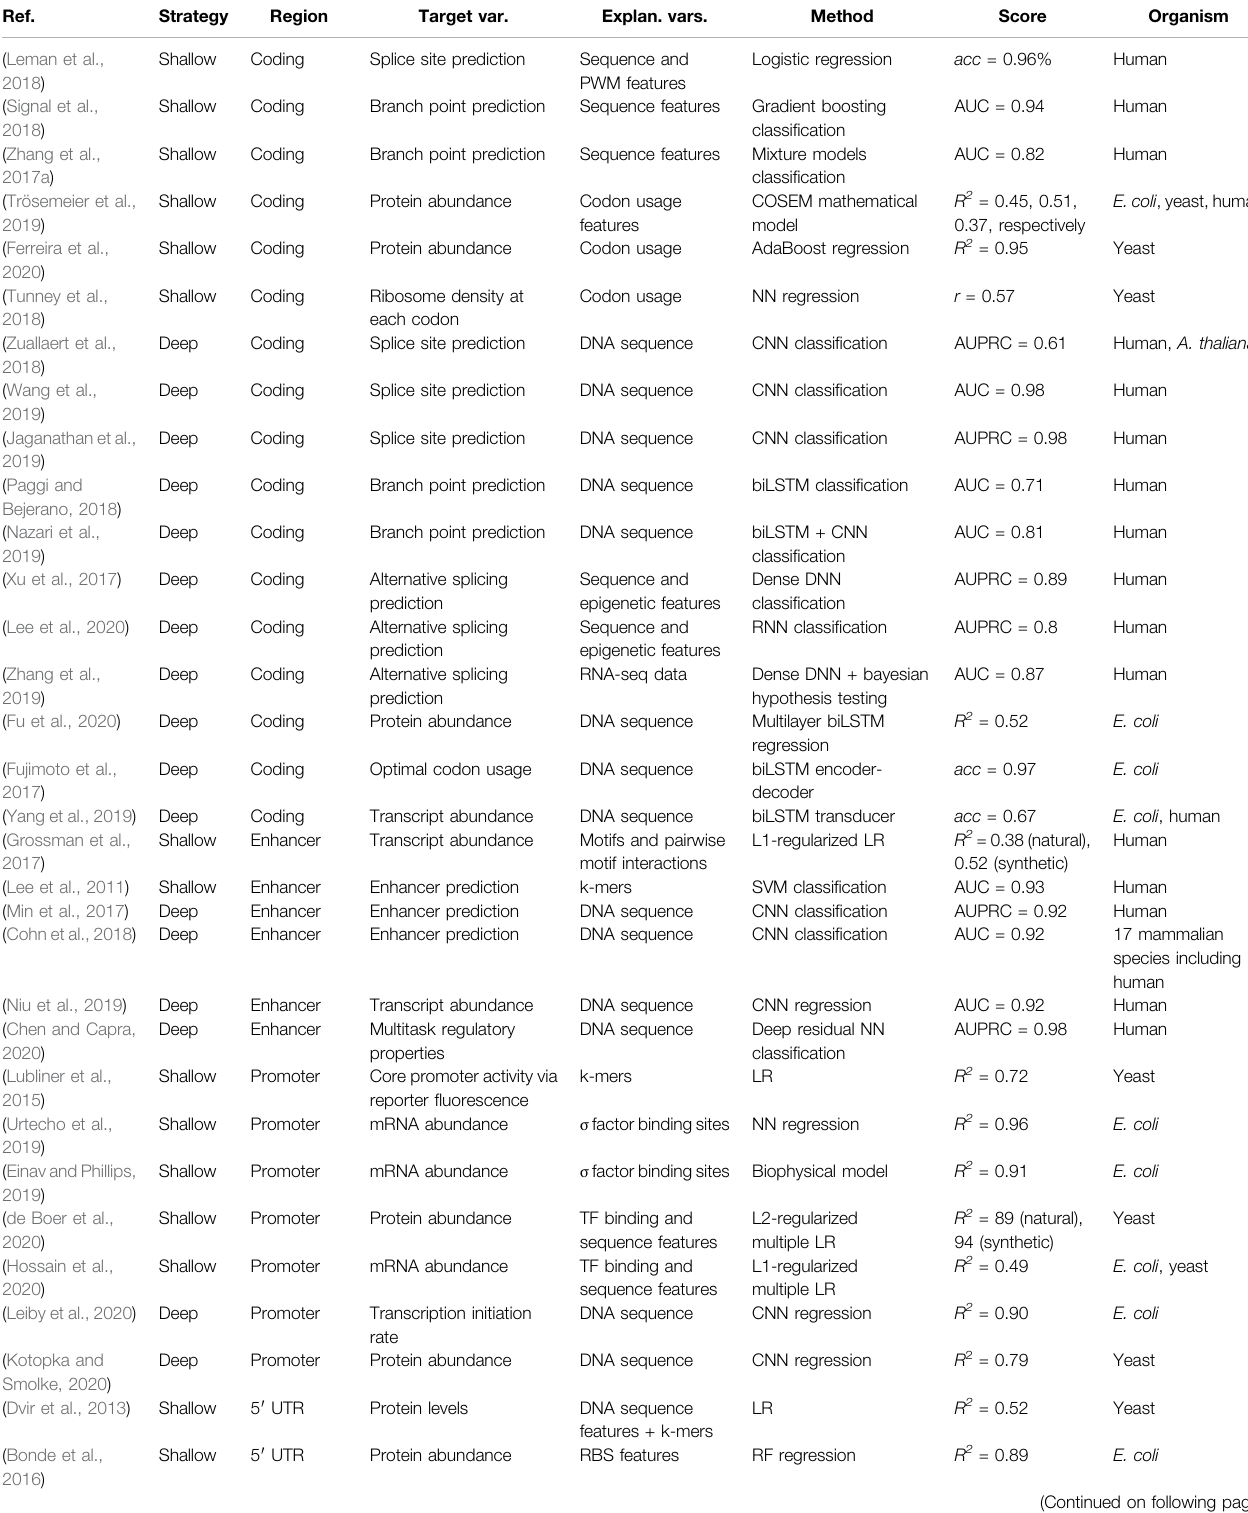
TABLE 2 | Overview of studies modeling gene expression-related properties from separate regulatory or coding regions. Highest achieved or average scores are reported, on test sets where applicable, and include accuracy ( acc ), area under the receiver operating characteristic curve (AUC), area under the precision recall curve (AUPRC), the coef fi cient of variation ( R 2 ) and Pearson ’ s correlation coef fi cient ( r ).